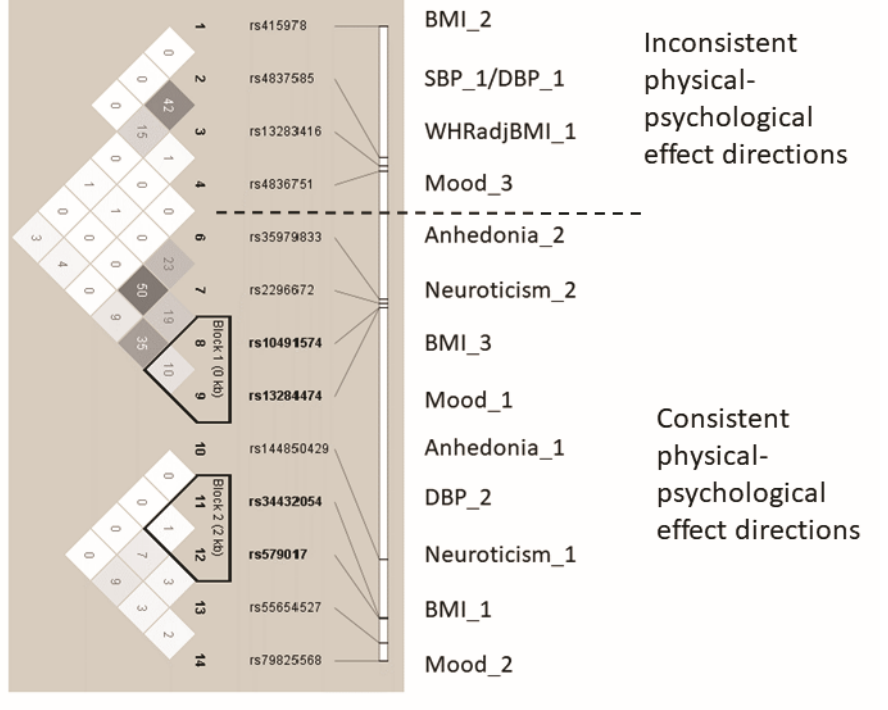
Figure 9. LD Structure of the ASTN2 locus and associations with psychological and physical phenotypes.